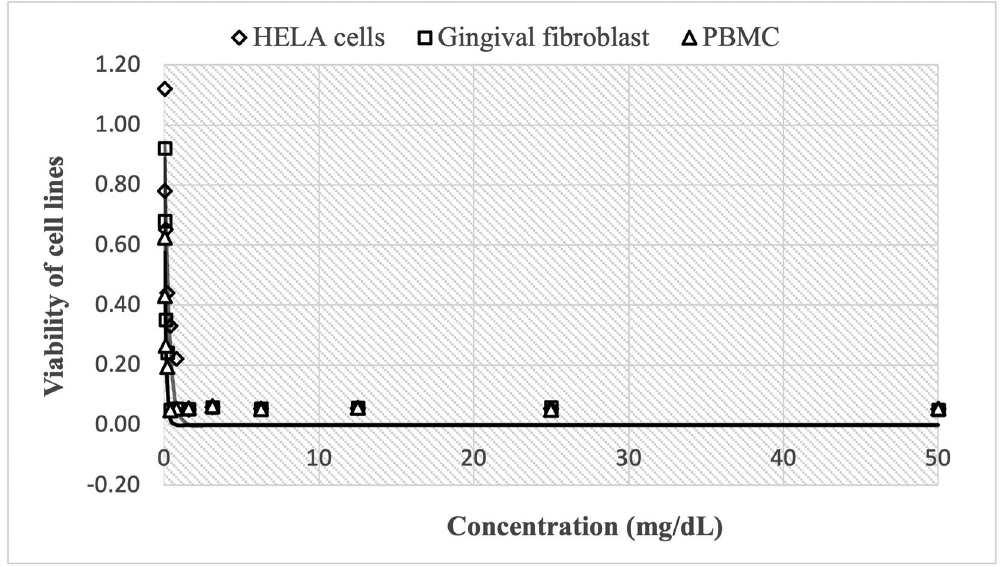
Figure 1. Viability of cell lines by effect of concentrations of ethanolic extracts of propolis. The cytotoxic effect of Peruvian propolis is shown in Figure 1, with high cell viability at concentrations of 0.24 mg/mL, reaching 1.120 (cid:4) 0.012 Henrietta Lacks cells (HELA cells), 0.922 (cid:4) 0.011 human gingival fibroblasts (HGF-1) and 0.624 (cid:4) 0.002 peripheral blood mononuclear cells (PBMCs cells), decreasing rapidly to 0.052 (cid:4) 0.002, 0.051 (cid:4) 0.001 and 0.055 (cid:4)